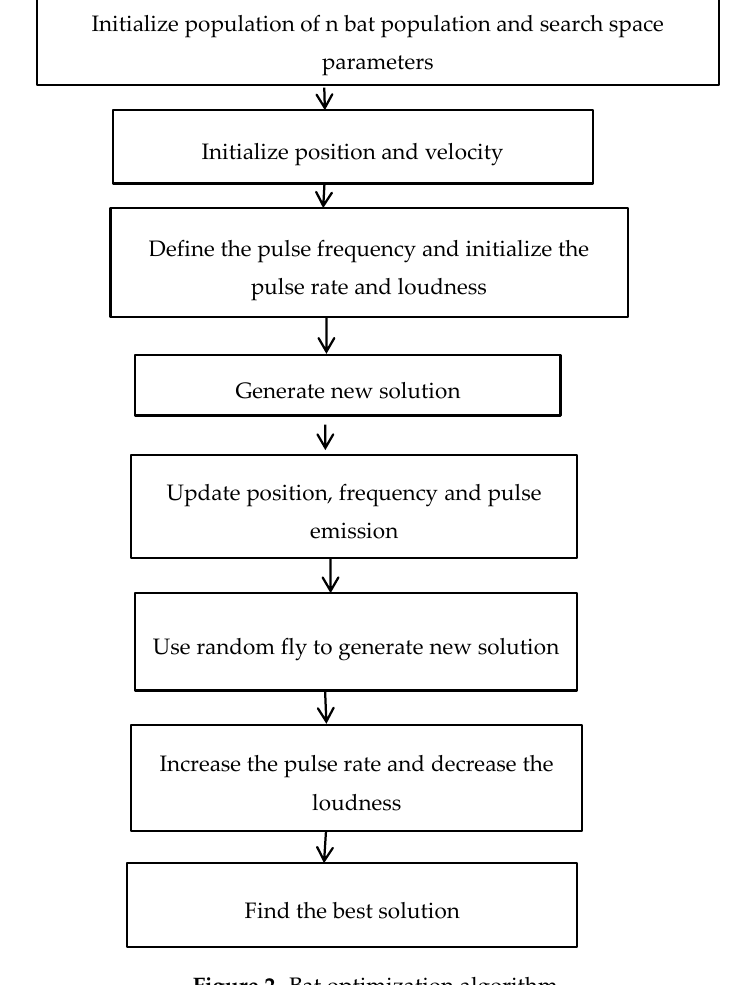
Figure 2. Bat optimization algorithm.